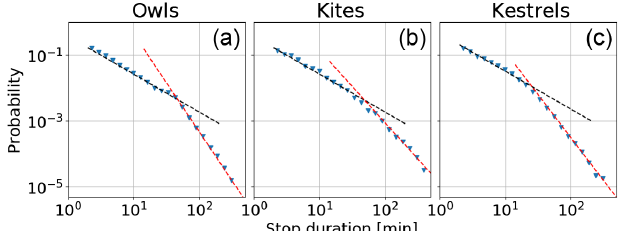
FIG. 6. Distributions of stop durations Δ T (symbols), defined as the total time spent within single ARSs (see text), for owls (a), kites (b), and kestrels (c), all adults. The dashed black and red lines are power laws, presenting a behavioral switch from Δ T 1 . 15 for shorter Δ T for all three species to Δ T 2 . 97 ; Δ T 2 . 20 , and Δ T 2 . 61 for longer Δ T , with typical transition times (when the two slopes intersect) of Δ T ¼ 45 , 48, and 36 min in panels (a), (b), and (c),